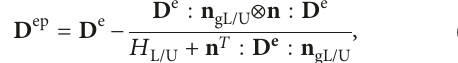
ln p plane is used ′ −